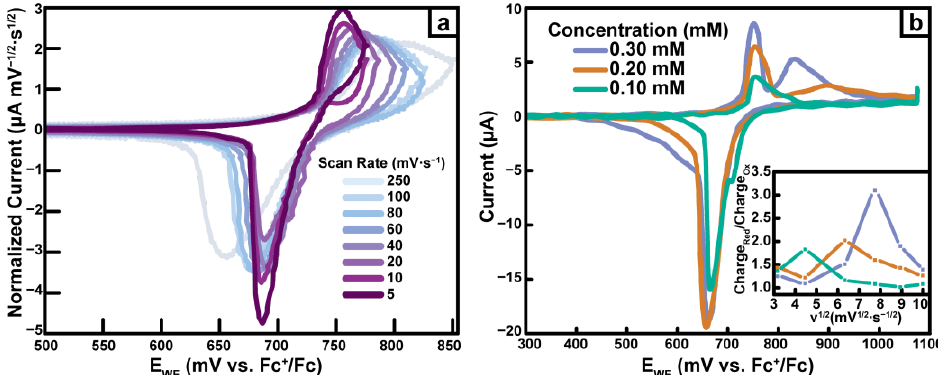
Figure 5. ( a ). Cyclic voltammograms of Pd(dppf)TPT (0.30 mM) with varying potential window and scan rate (5-250 mV ∙ s − 1 ) in DCM (100 mM TBAPF 6 ).; current is normalized to the scan rate ( ν ) by dividing by ν 1/2 . ( b ). Cyclic voltammograms of Pd(dppf)TPT (0.10-0.30 mM) at 10 mV ∙ s − 1 in DCM (100 mM TBAPF 6 ); the inset shows a plot of Charge Red /Charge Ox vs. ν 1/2 . Each voltammogram is taken from the second CV cycle.